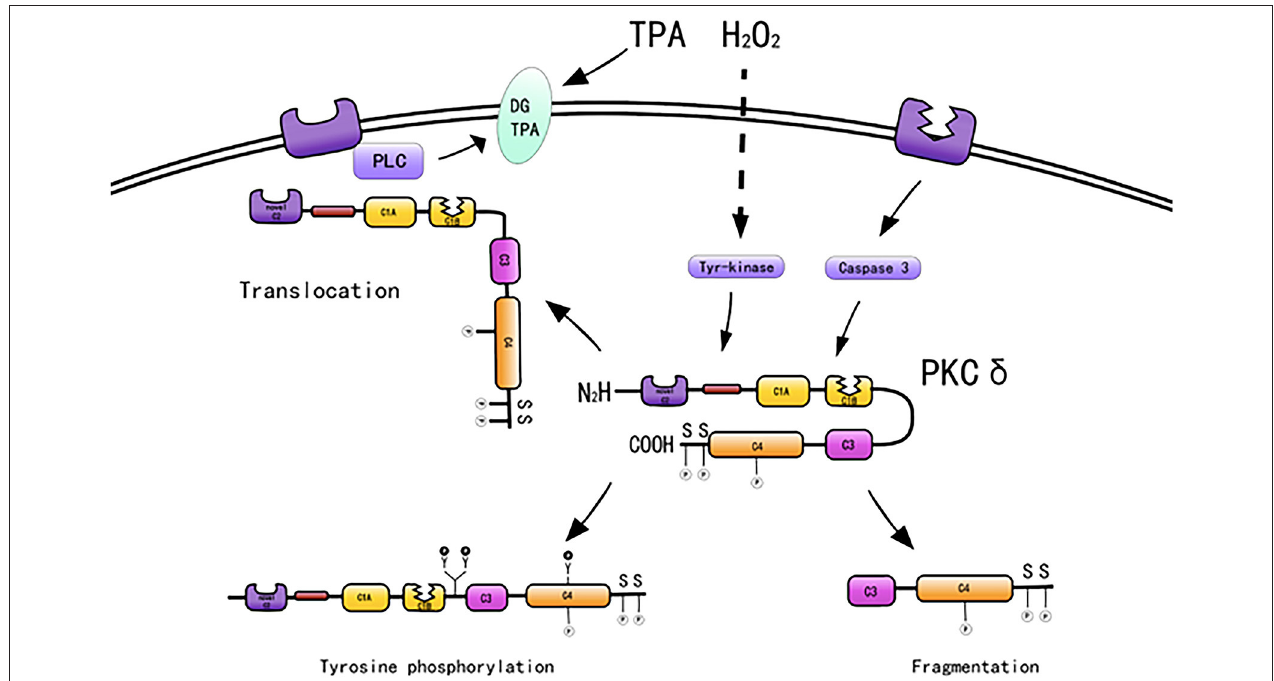
FIGURE 2 | Activation mechanisms of PKC- δ [adapted from Ushio et al. (50)].